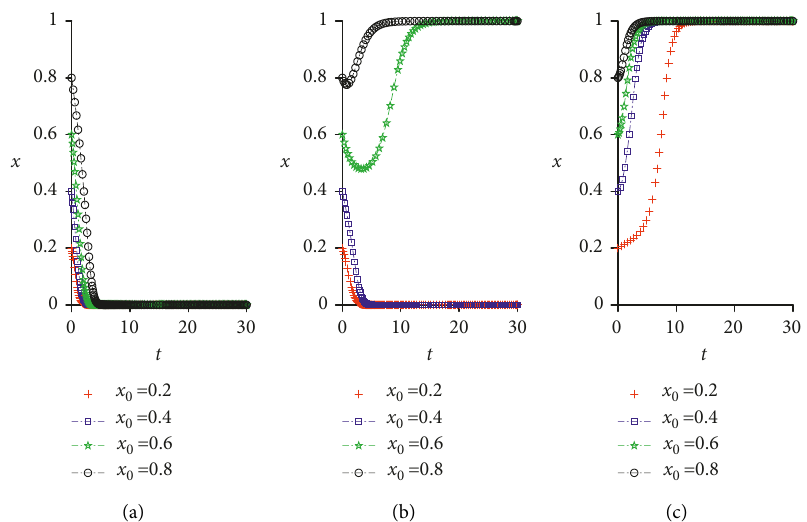
Figure 9: Impact of P on system evolution. Comparing (a), (b), and (c), as P (the fine to the party that adopts a noncooperation strategy) increases, the probability of the system evolving to the ideal state increases. (a) P